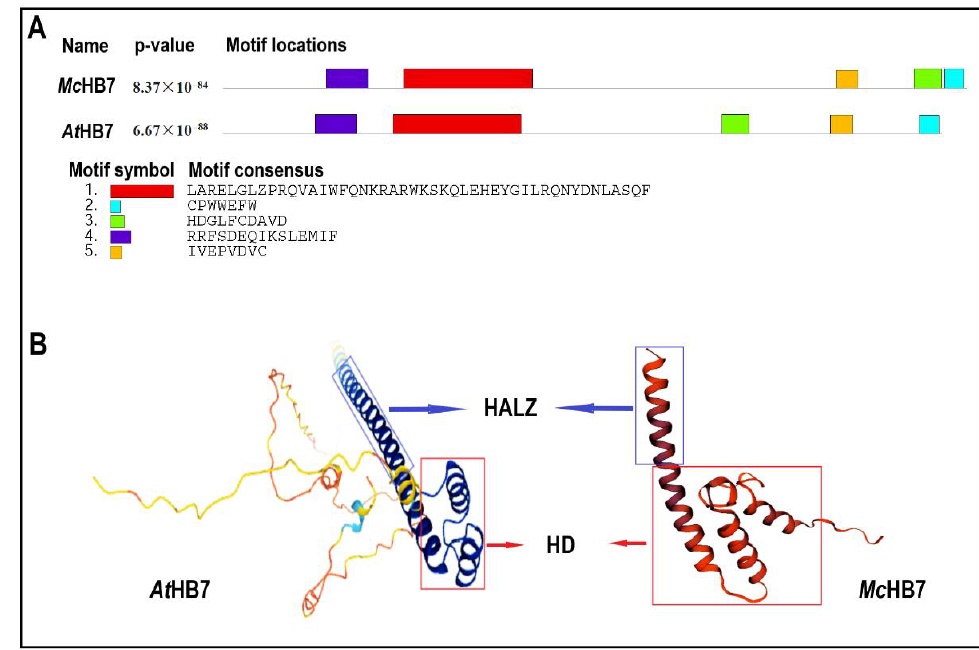
Figure 1. Sequence analysis of Mc HB7 and At HB7. ( A ) Conserved motifs of Mc HB7 and At HB7. ( B ) Three-dimensional structure of At HB7 and the predicted structure of Mc HB7. HD, homeobox domain. HALZ, homeobox-associated leucine zipper.